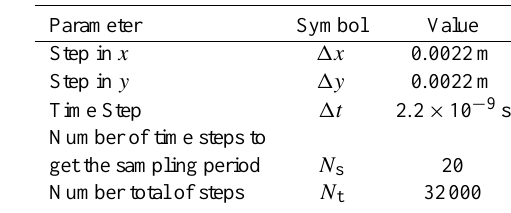
Table 5. Summary of parameters changed from those presented in Table